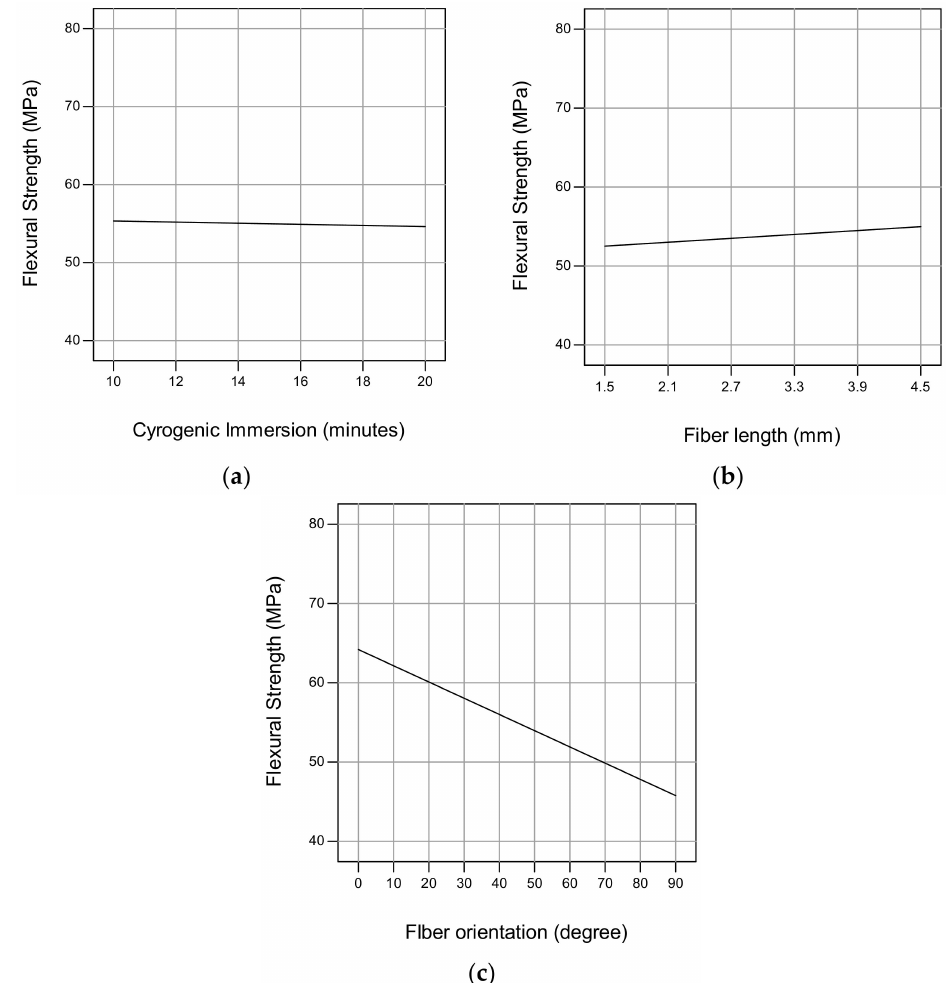
Figure 3. Effect of the individual factors on flexural strength: ( a ) effect of cryogenic treatment; ( b ) effect of fiber length; ( c ) effect of fiber